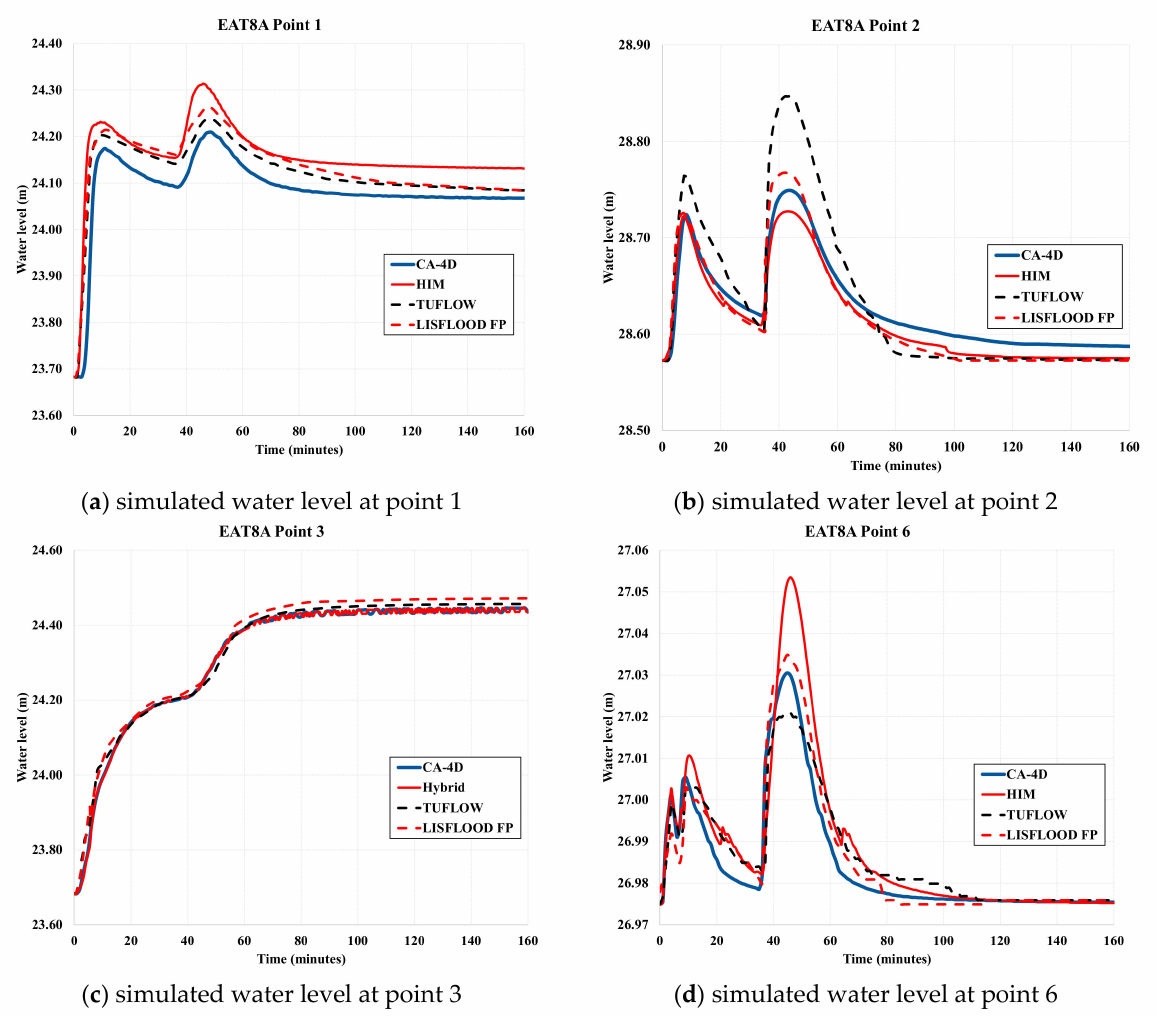
Figure 14. Temporal variation in water level for EAT8A at points 1, 2, 3, and 6; comparison among the CA-4D, HIM, TUFLOW, and LISFLOOD-FP models; ( a ) simulated water level at point 1; ( b ) simulated water level at point 2; ( c ) simulated water level at point 3; ( d ) simulated water level at point